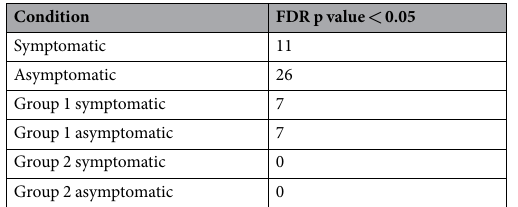
Table 1. Features associated with clinical presentation or phylogenomic